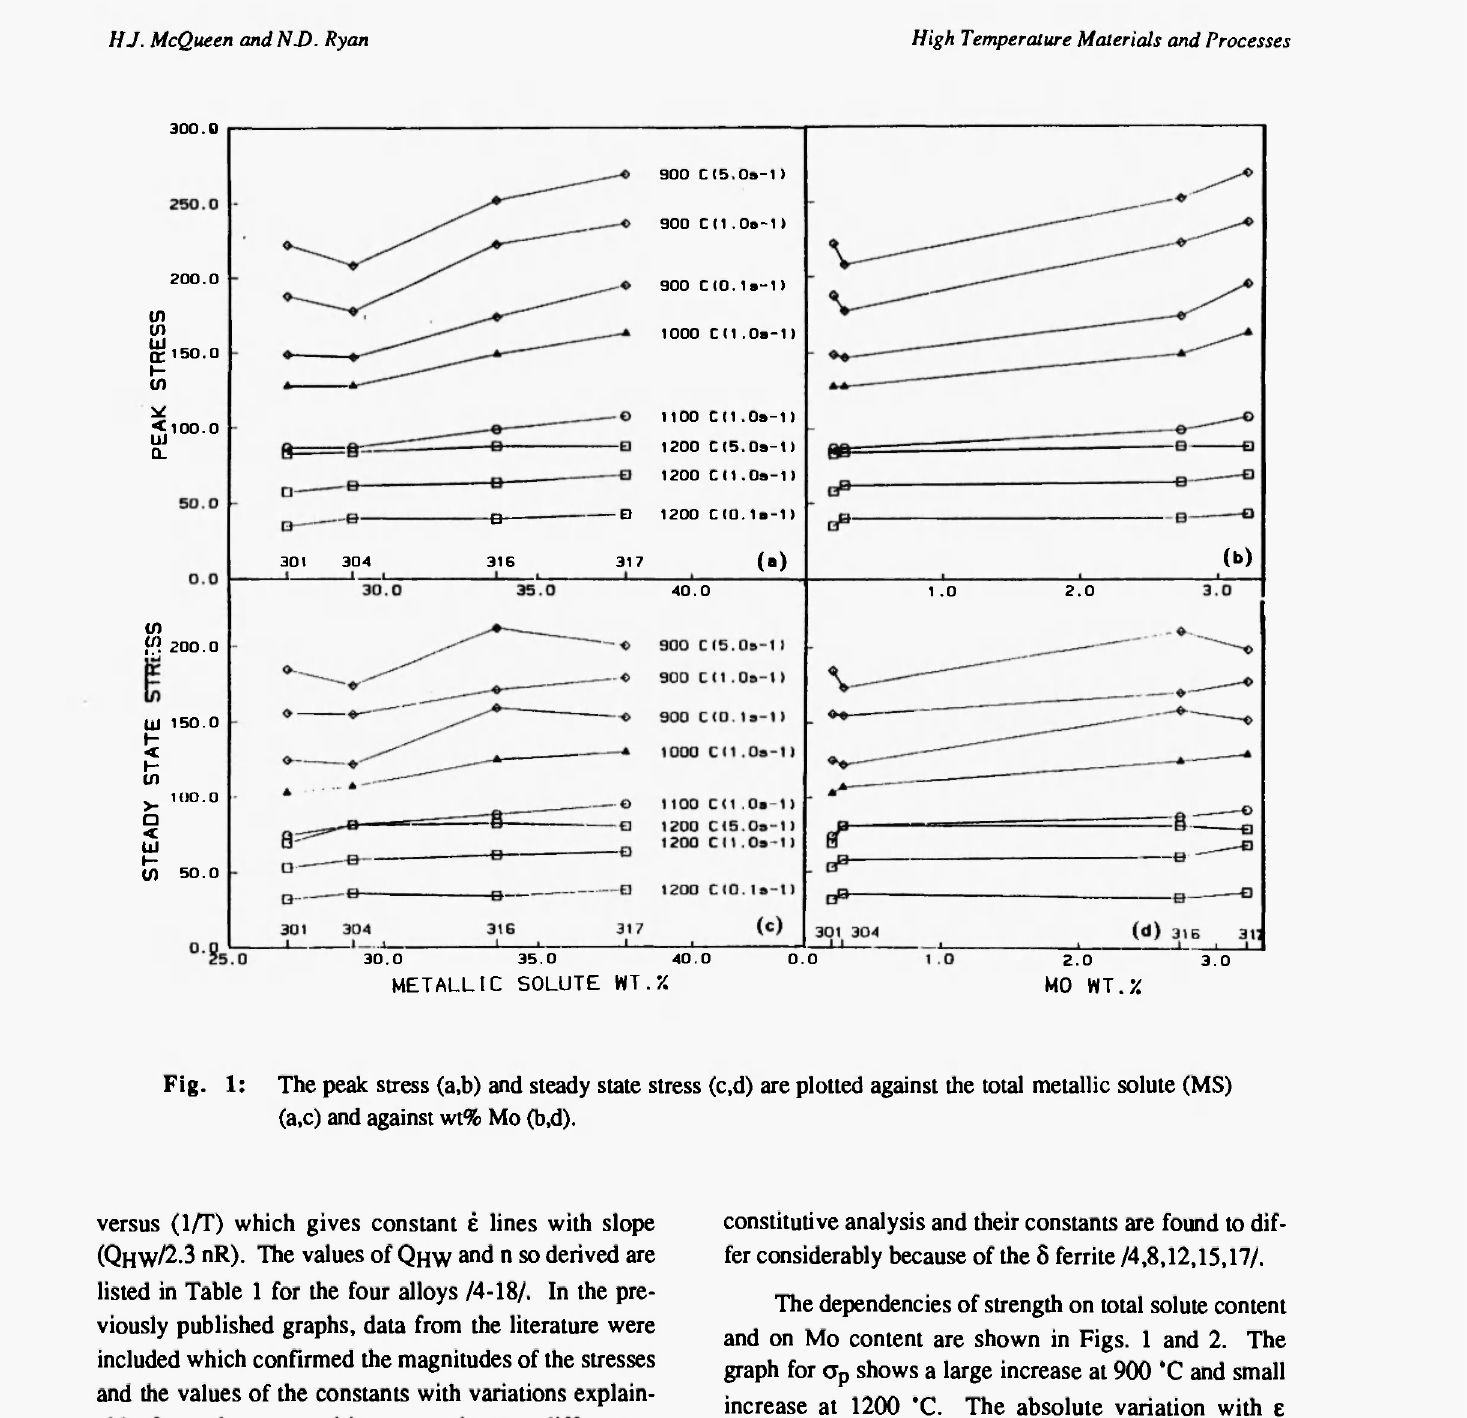
Fig. 1: The peak stress (a,b) and steady state stress (c,d) are plotted against the total metallic solute (MS) (a,c) and against wt% Mo